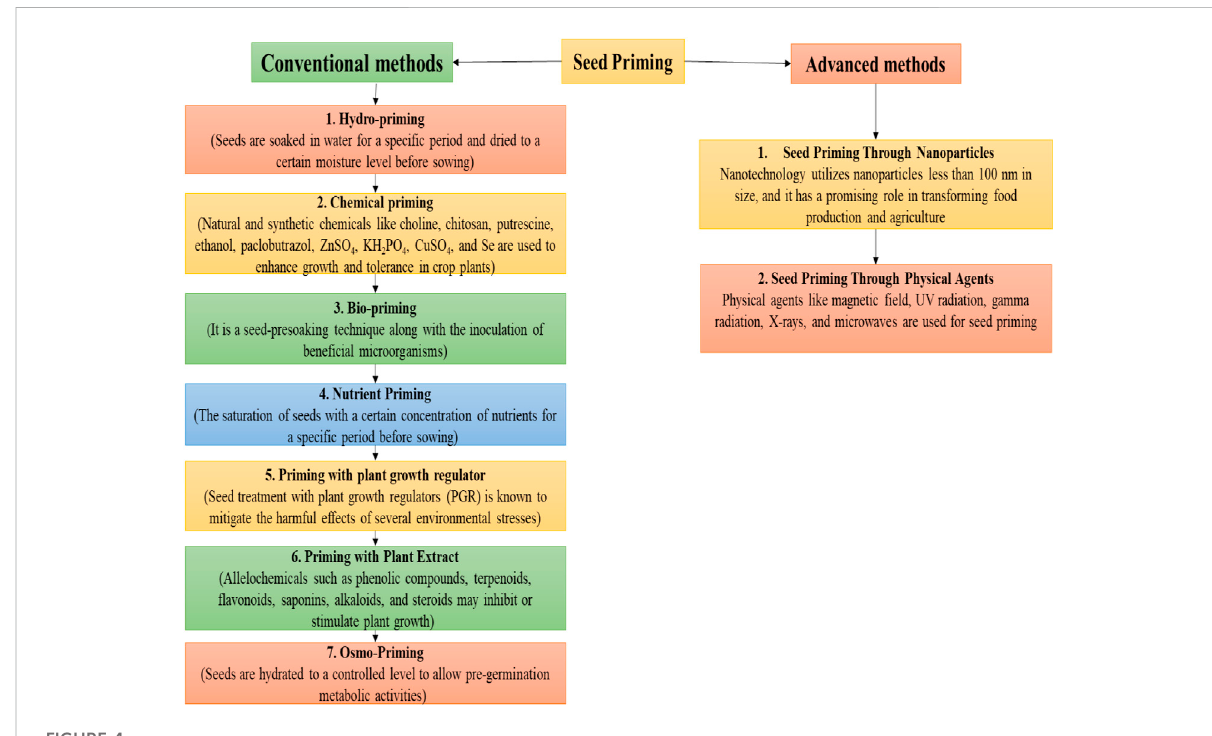
FIGURE 4 Schematic diagram of different seed priming